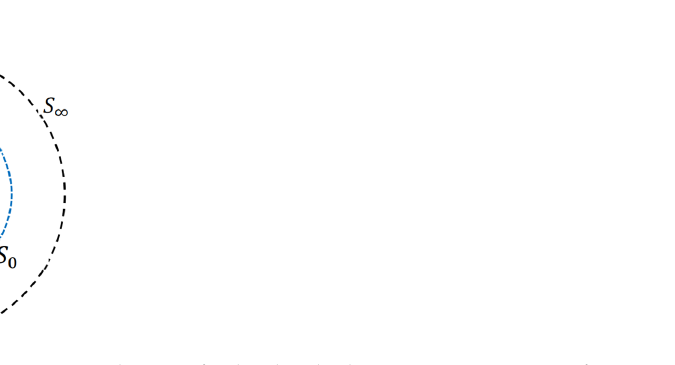
Figure 10. The electromagnetic radiation of a dipole. Shadow: evanescent region for TM n 0